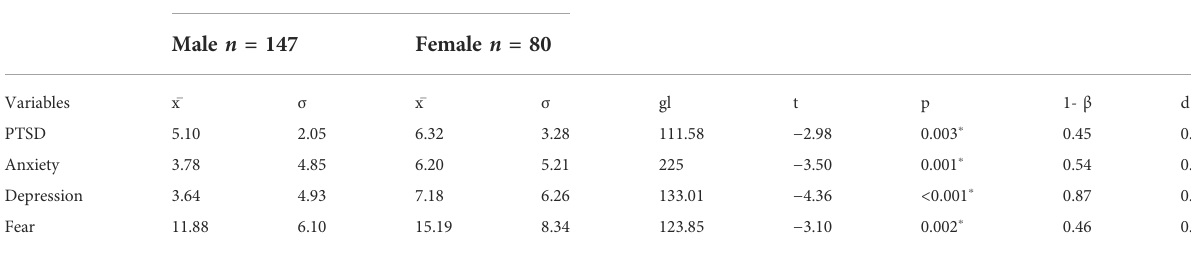
TABLE 5 Gender differences in PTSD, anxiety, depression, and fear scores.